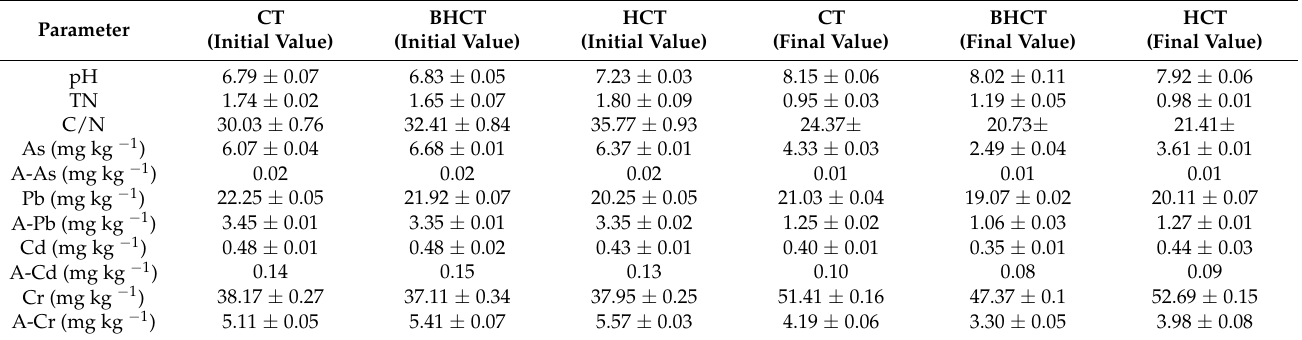
Table 2. The main physicochemical properties of CT, HCT, and BHCT in the initial and final stages.